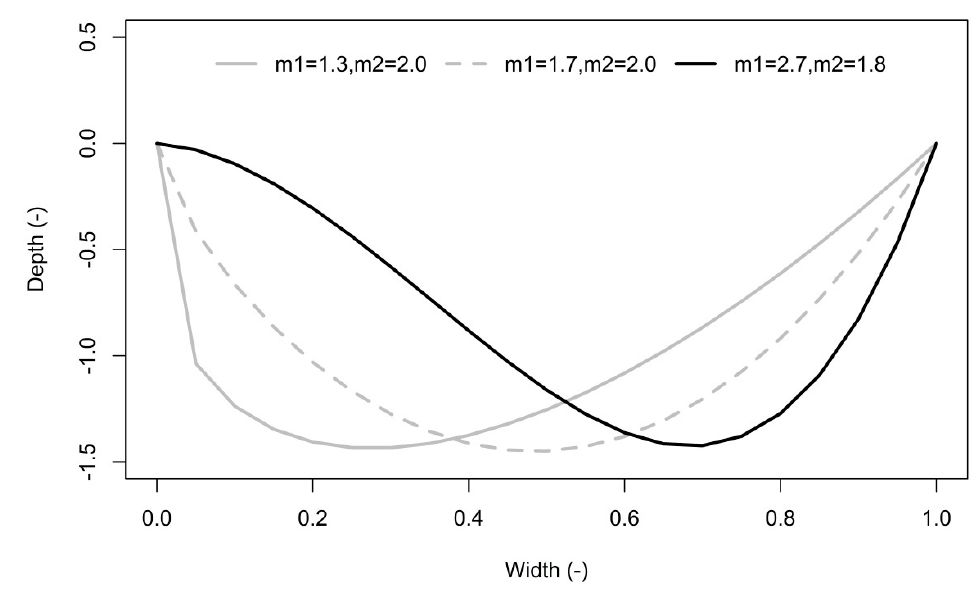
Figure 2. Example showing ability of the proposed bathymetric model to schematize a cross-section.